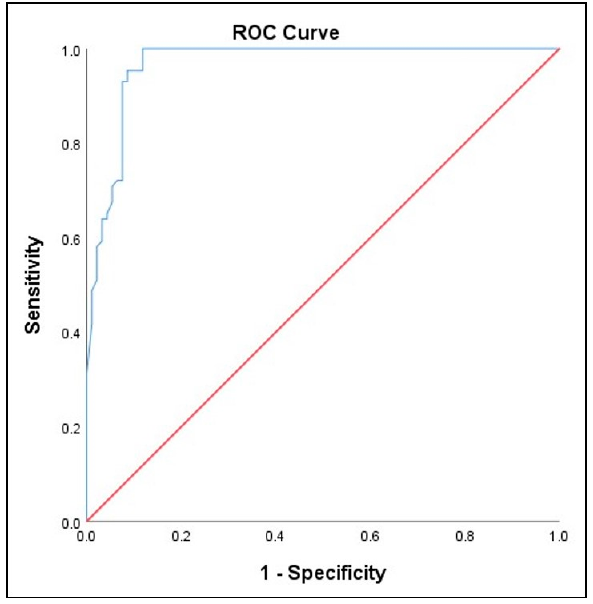
Figure 6. Overall model’s accuracy is represented in AUC-ROC curve.